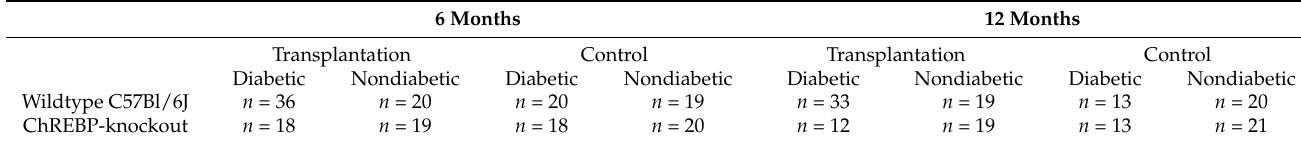
Table 1. Experimental and control